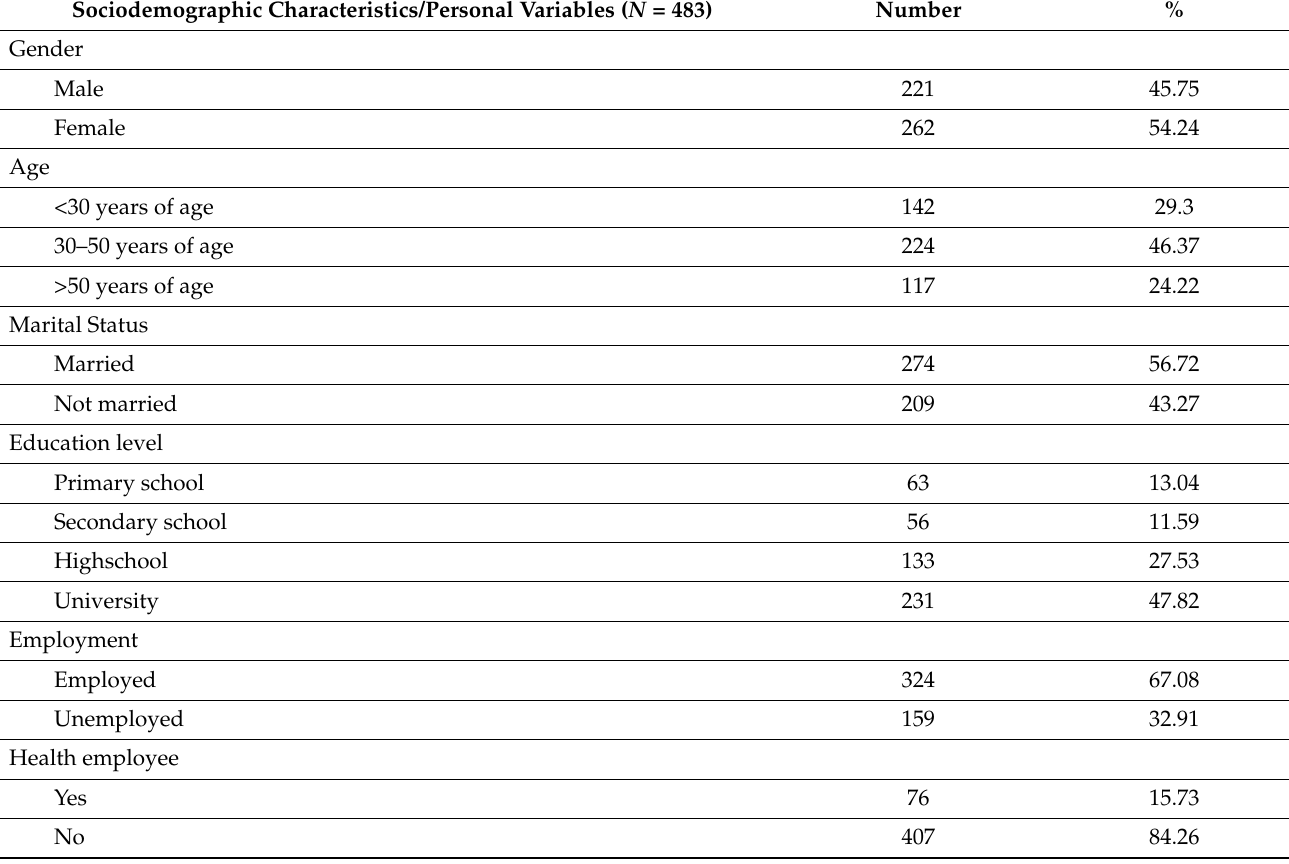
Table 1. Sociodemographic characteristics and personal variables of the